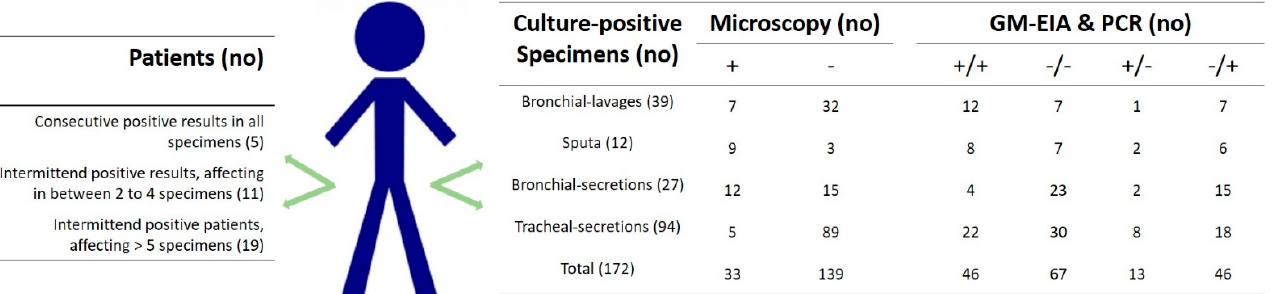
Figure 2. Overview of biological variance in Aspergillus sp. Culture-positive specimens ( n = 172) and patients ( n = 35). Table 3. Overview of species detected by culture and Aspergillus